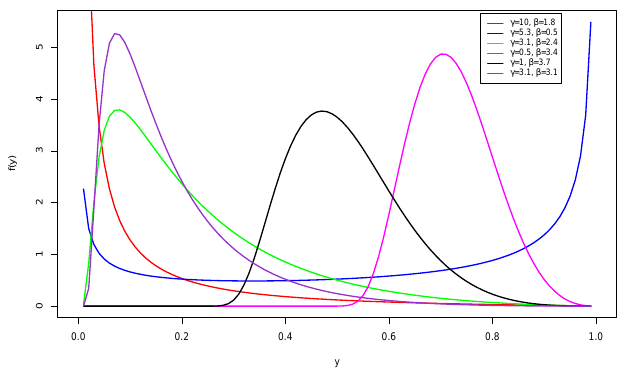
Figure 4. PDF plots of the SCUGHN